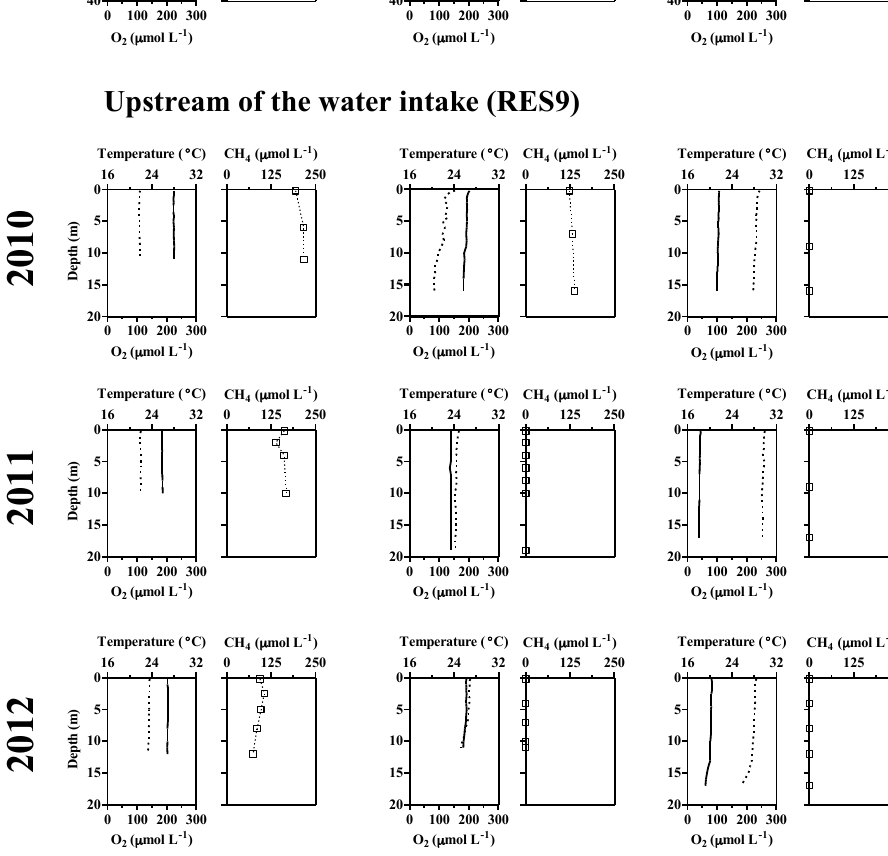
Figure 2. Vertical profiles of temperature, oxygen, and methane concentrations at stations RES1 and RES9 in the Nam Theun 2 Reservoir during the three seasons in 2010, 2011, and